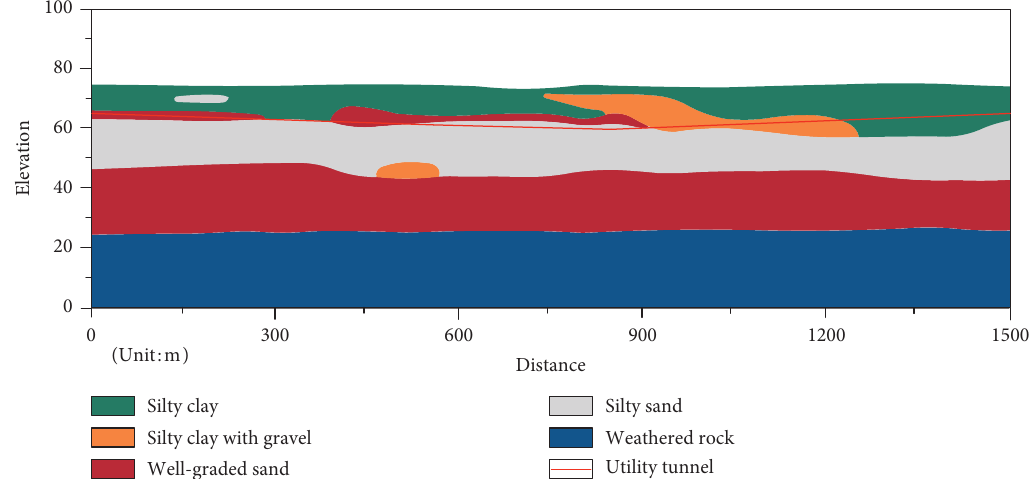
Figure 1: Soil layers of the engineering site.